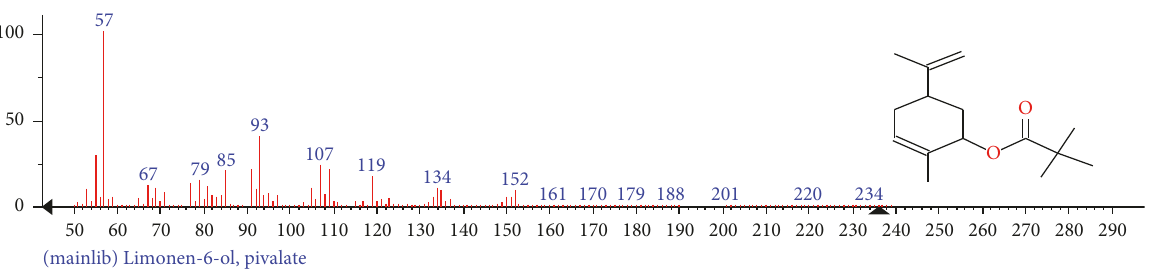
Figure 45: Mass spectrum of compound limonen-6-ol, pivalate of whole plant hexane fraction of Achillea wilhelmsii (WHFAW).